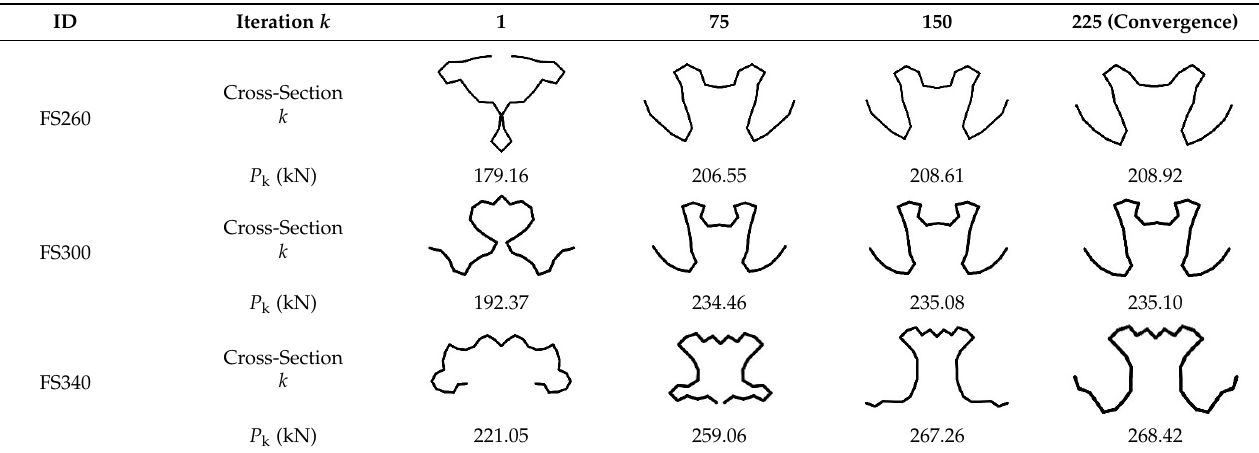
Table 2. Summary of cross-section optimization process.